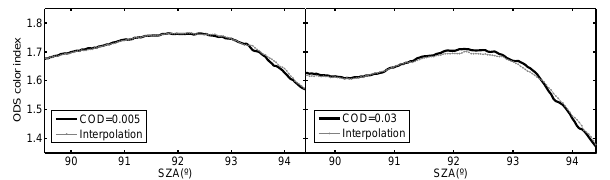
Figure 11. ODS color index for COD = 0 . 005 and 0.03, and a cloud altitude h = 12km interpolated (grey circles) from pre-calculated LUT COD and the ODS color index (black solid lines) simulated by the Monte Carlo